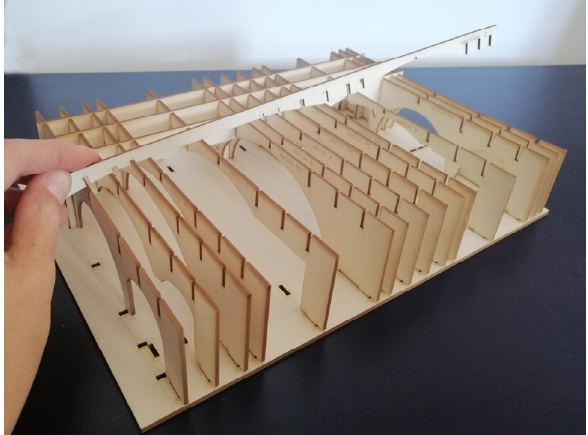
Figure 11 . 3D conceptual model for the digital fabrication of the tactile model of the vault of Palazzo Mazzonis